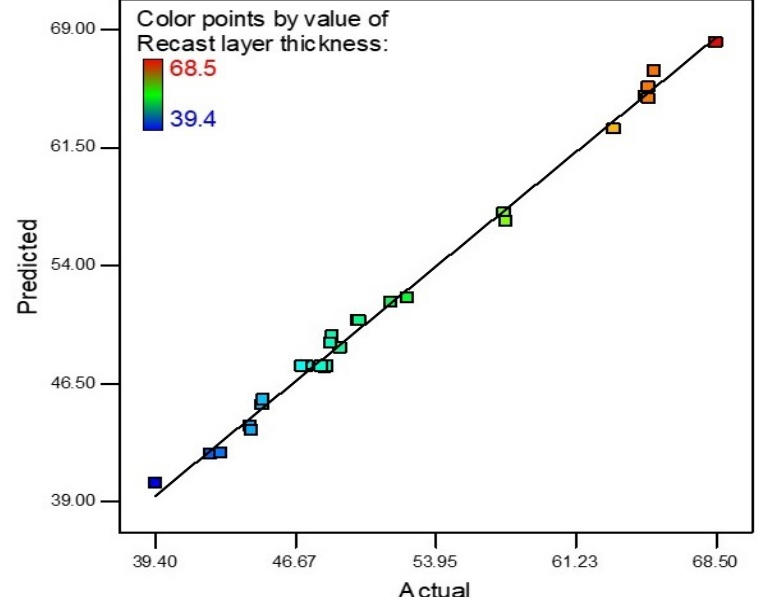
Figure 9. RLT predicted vs. actual values. Table 9. Recast layer thickness